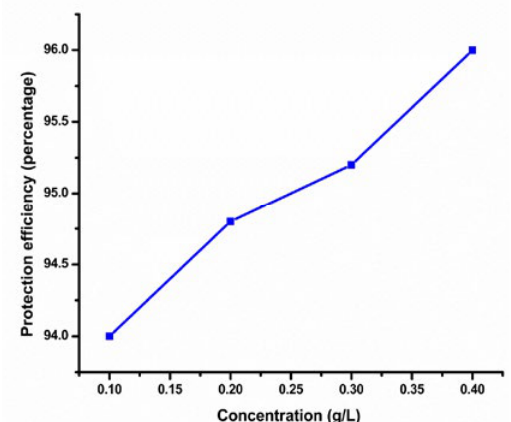
Fig. 3. Colorimetry results (Concentration vs. Protection efficiency) Fig. 2. Relationship between protection efficiency and concentration of the inhibitor at different immersion period